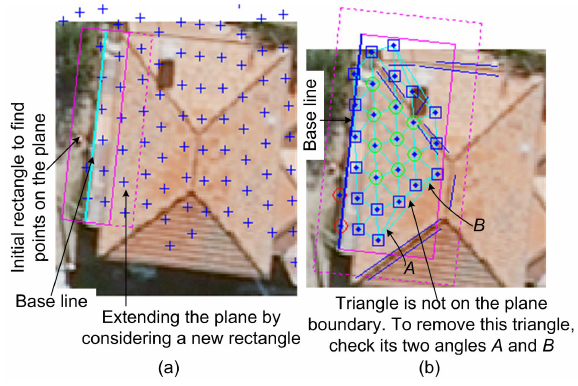
Figure 5: (a) Fitting a plane to the LIDAR points and (b) finding the boundary points of the